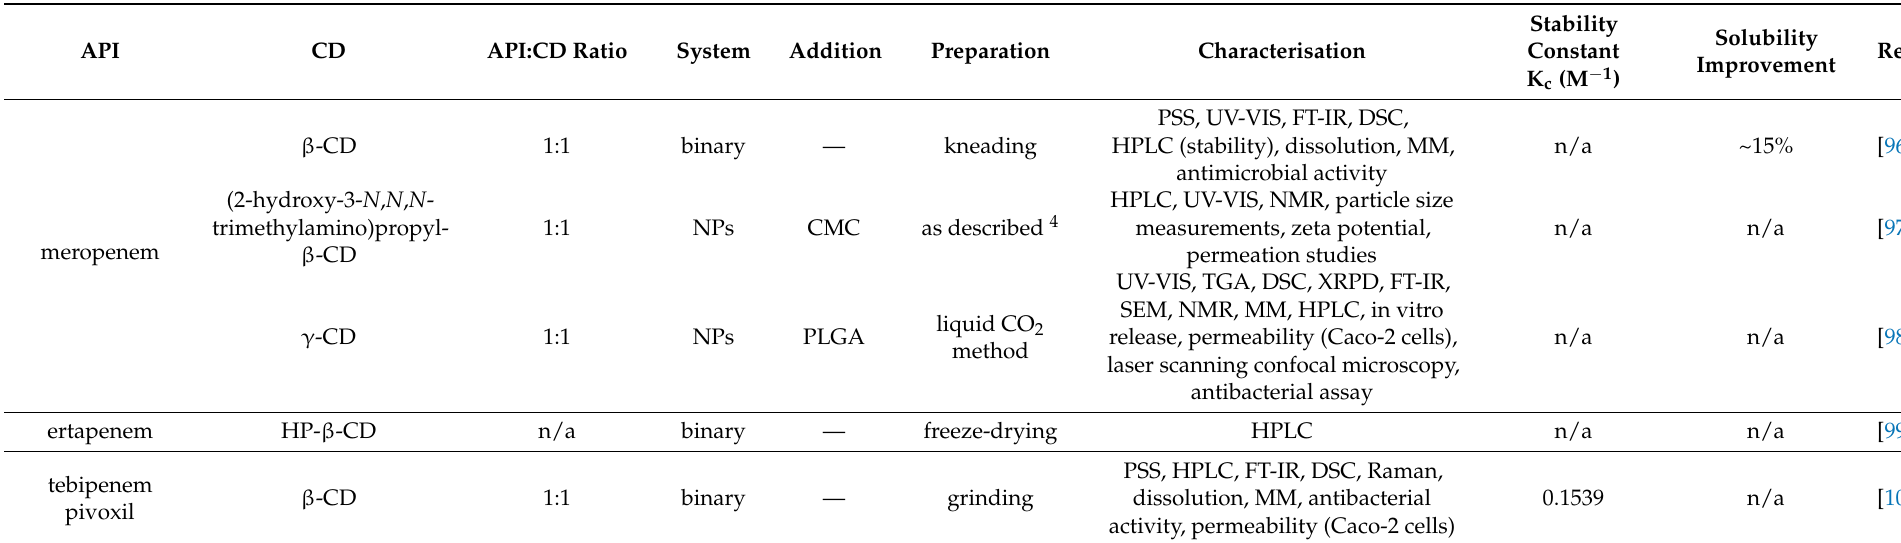
Table 3. Detailed information of carbapenem complexes on the types of CDs used, methods of complex preparation, and techniques used to characterise the obtained products